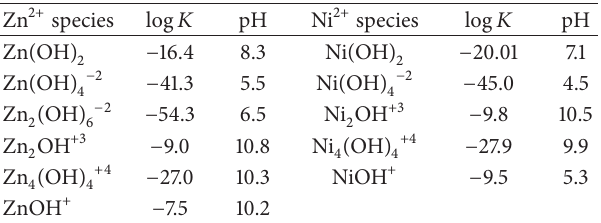
Table 2: Hydrolysis constants (log 𝐾 ) and pH of Ni 2+ and Zn 2+